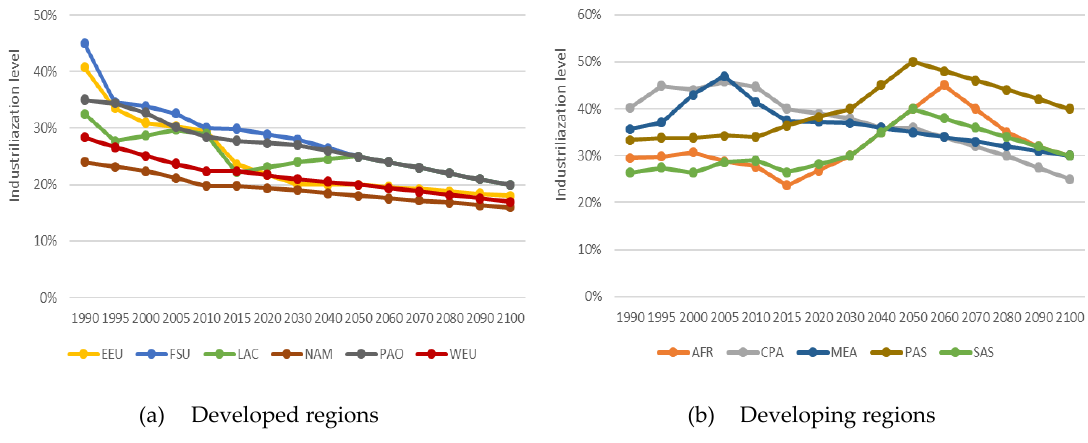
Figure 3. The predicted industrialization results for 11 regions. Note: (a) Developed regions; (b) Developing regions.